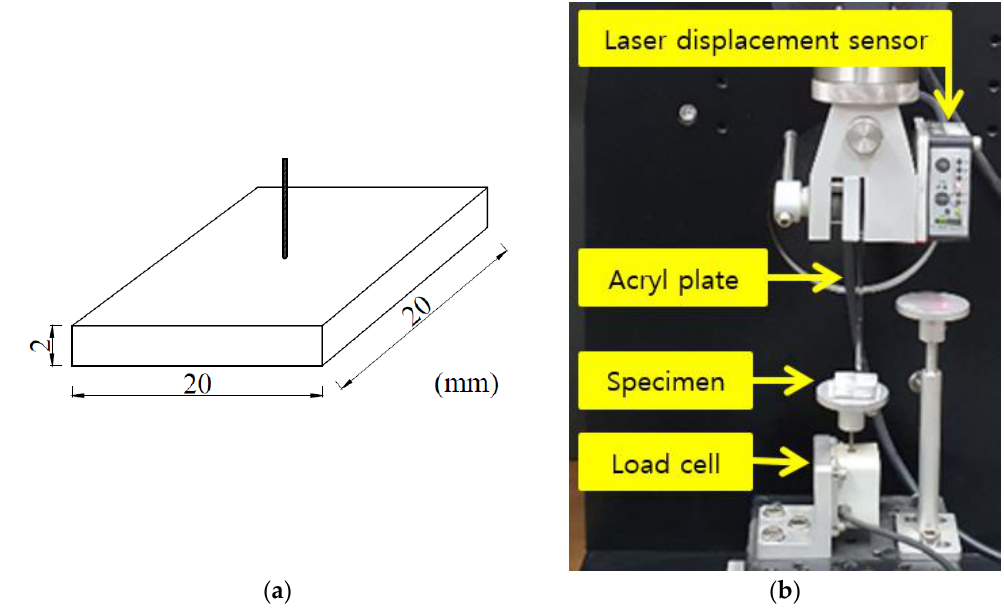
Figure 3. Fiber pullout test: ( a ) dimensions of specimen and ( b ) test setup.